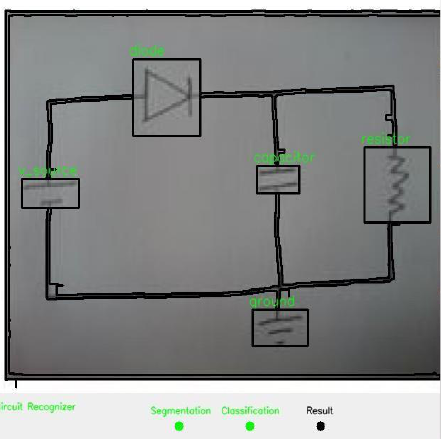
Fig. 3: Final Result of reconstructing lines of the